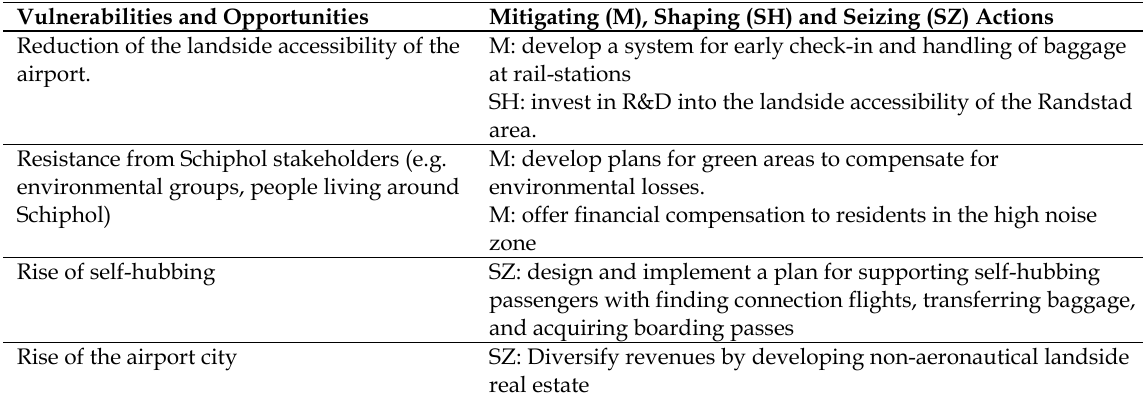
Table 2. Certain Vulnerabilities, and Responses to Them Vulnerabilities and Opportunities Reduction of the landside accessibility of